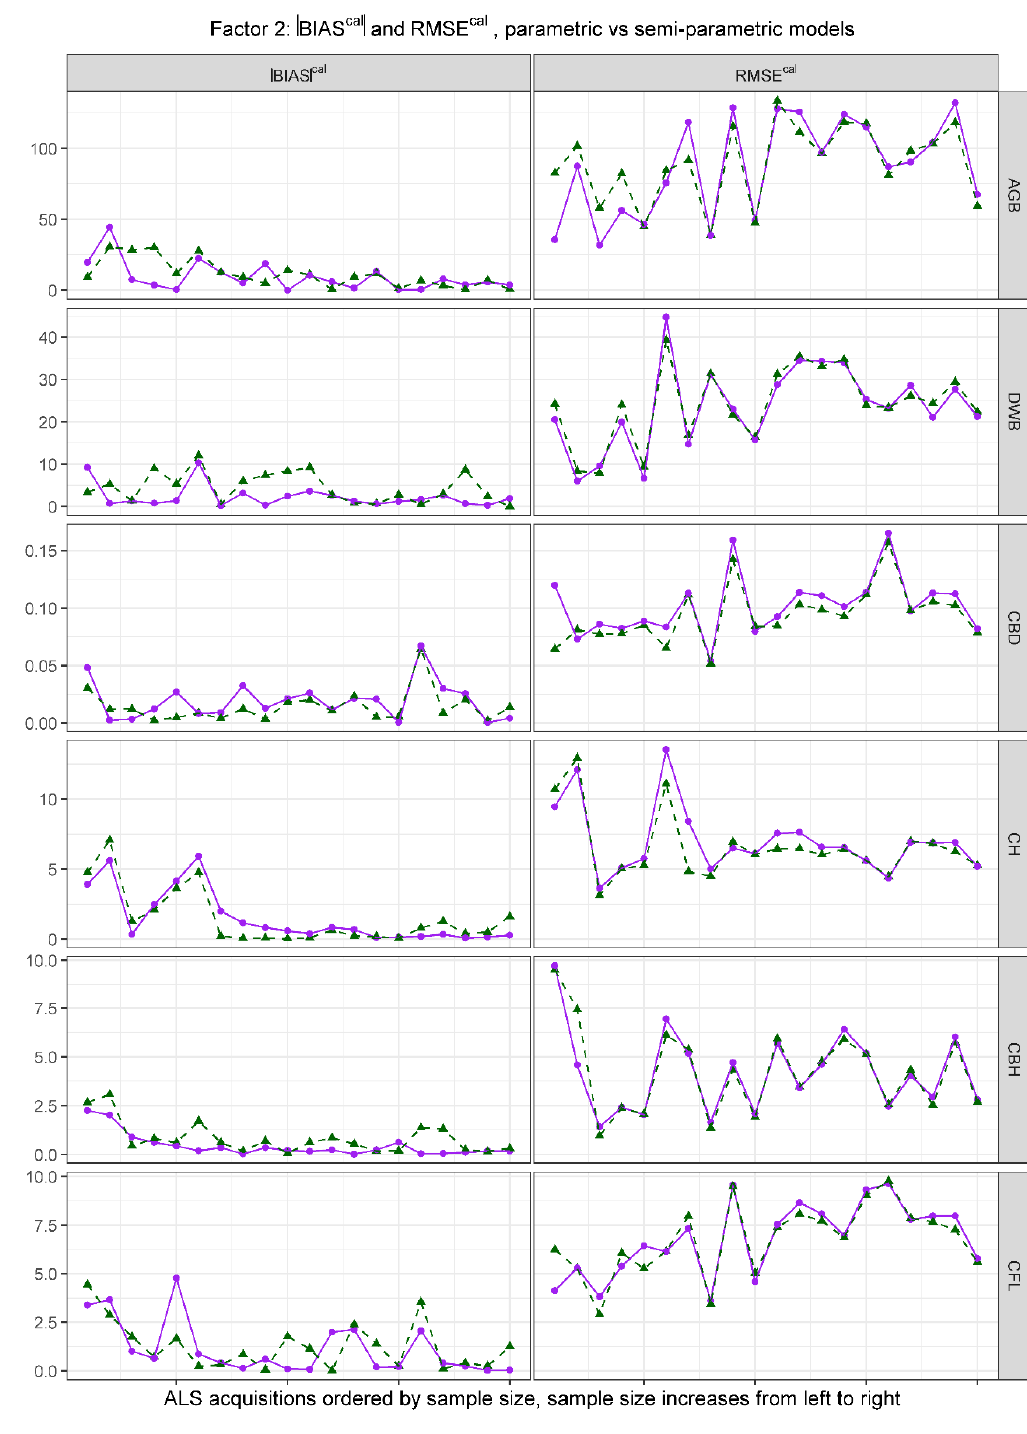
(cid:12) (cid:12) (cid:12) (cid:12) cal (cid:12) RBIAS (cid:12) , and relative root mean squared error,